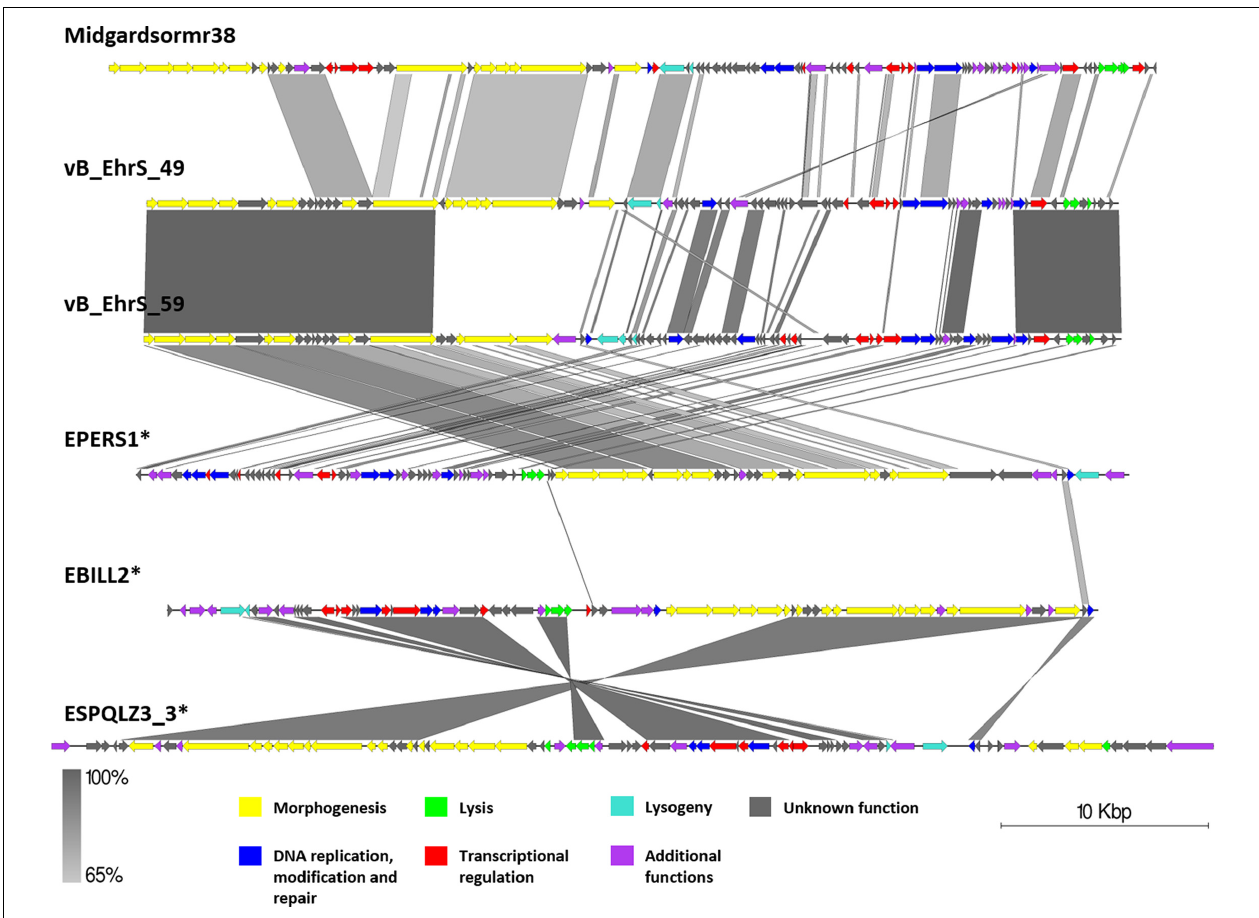
FIGURE 7 | Pairwise genome nucleotide sequence comparison of phages from the suggested cluster 3. Genomes are linearized and drawn to scale; scale bar indicates 10 thousand base pairs. Arrows representing open reading frames point in the direction of transcription and are color-coded according to the legend. Gray boxes between genomes represent regions of similarity and are gradient-colored according to their identity; darker shade of gray represents higher identity. Asterisk next to the phage name indicates a prophage derived from chromosome of Erwinia